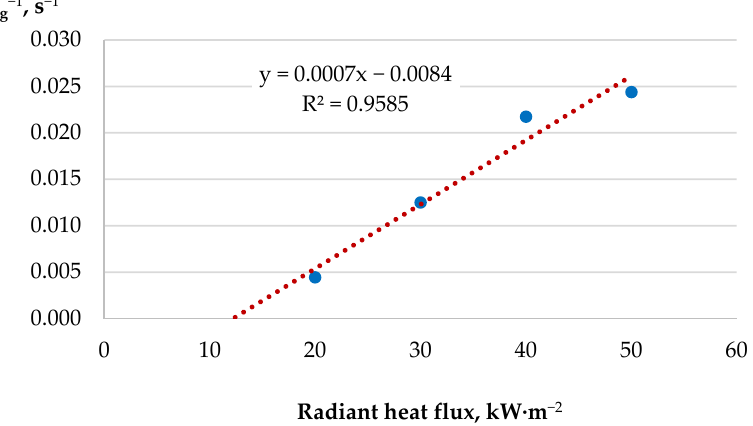
Figure 9. Reciprocal time results for piloted ignition of a PVC coaxial power cable.